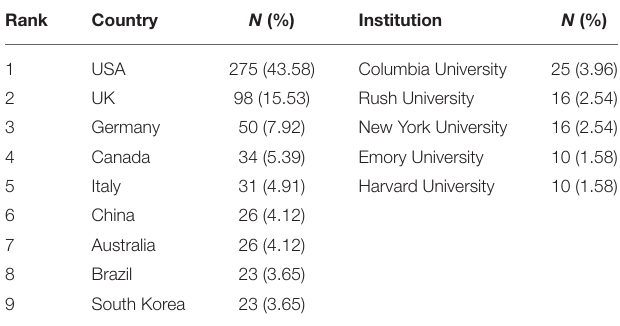
TABLE 1 | The top 9 countries and top five institutions of epilepsy with suicide. Rank